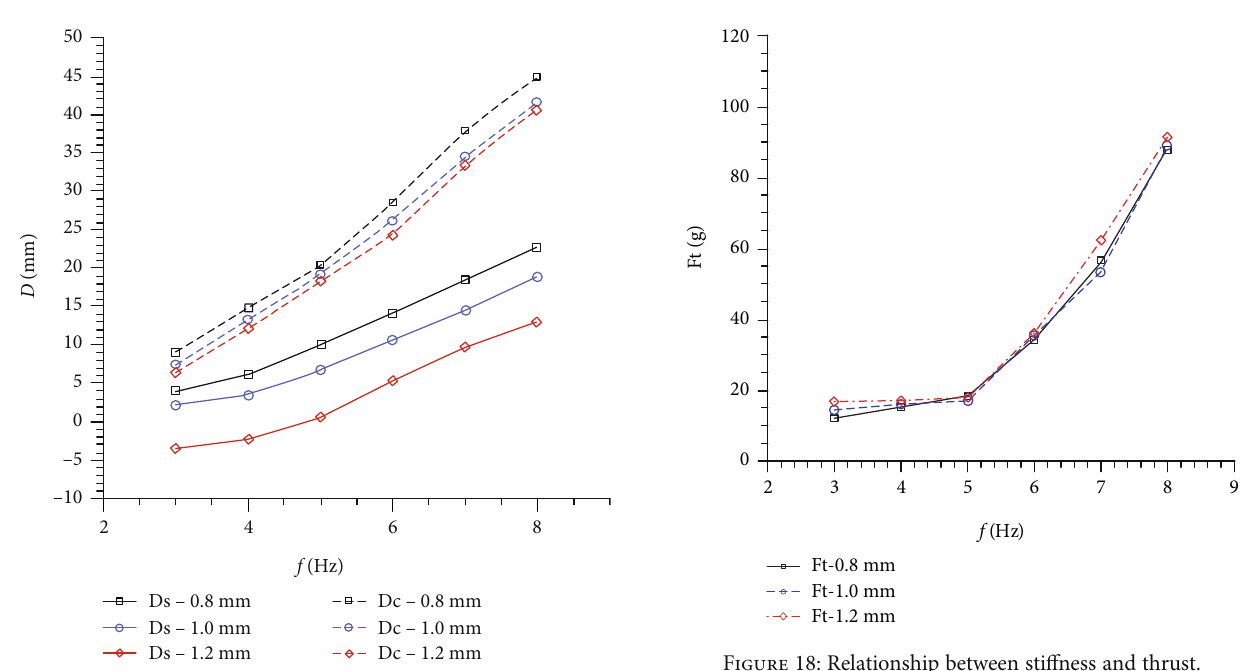
Figure 17: Spanwise and chordwise deformations vs. fl apping frequency.